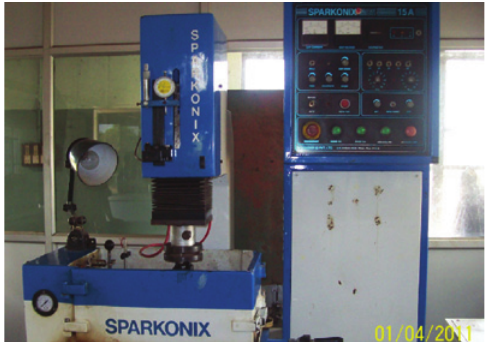
Figure 1 Electrical discharge machine